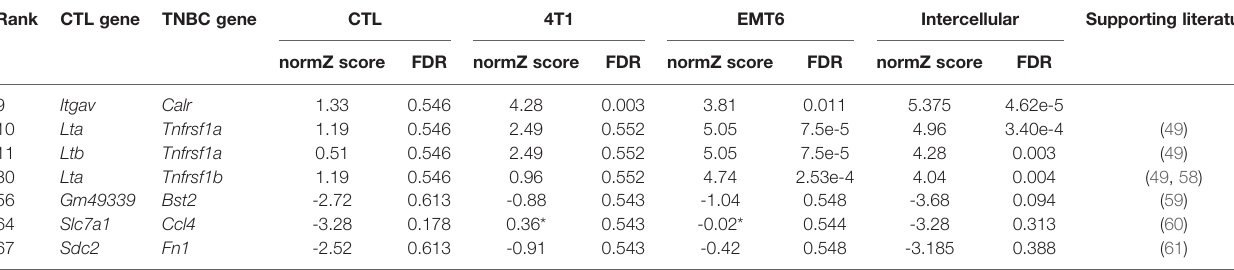
TABLE 1 | Highly ranked intercellular interactions for immunotherapeutic